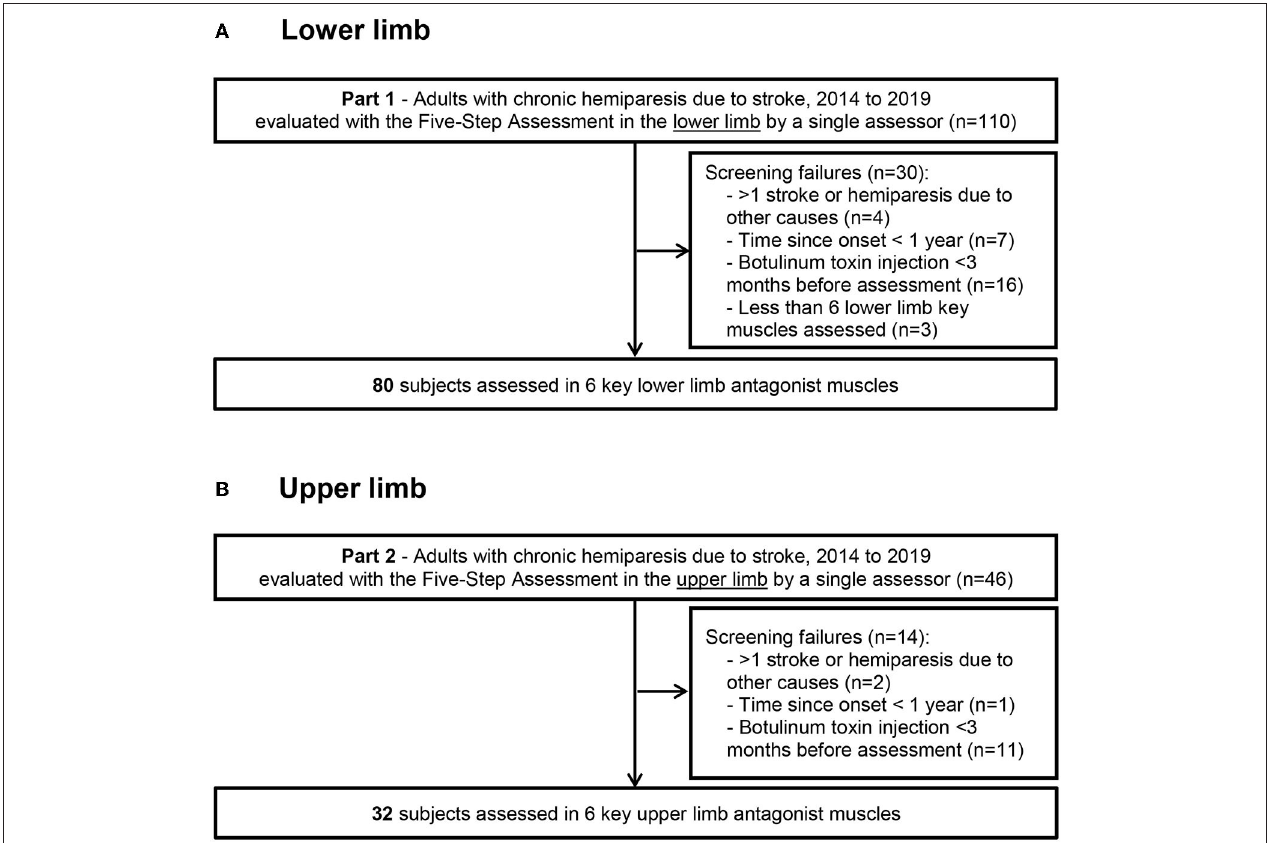
FIGURE 1 | Flow diagram Flow diagram for the lower limb (A) and upper limb (B) data